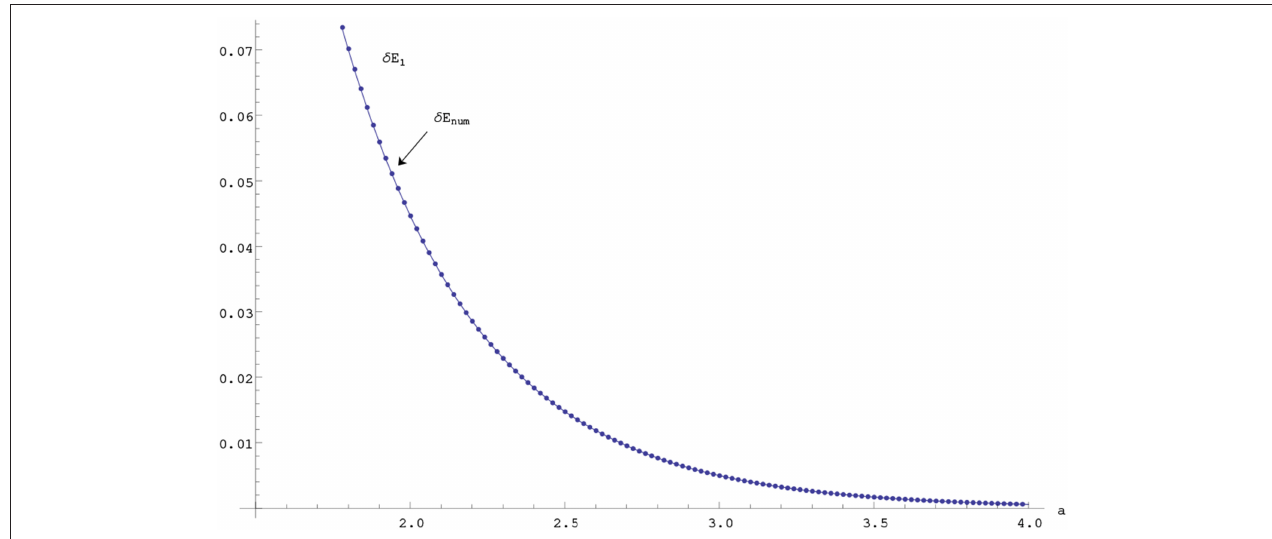
FIGURE 2 | Numerical and first order perturbation results for the splitting in the energy as a function of a for µ